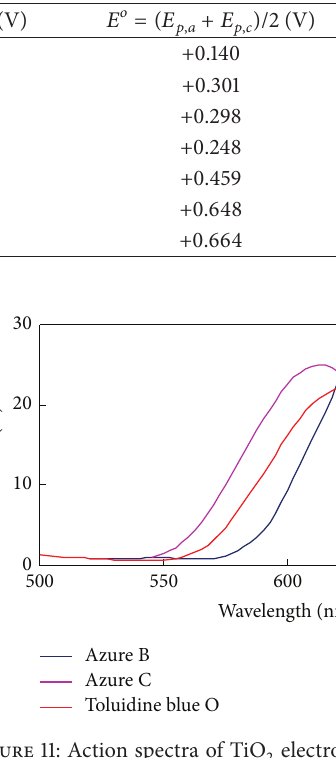
Figure 10: Photocurrent-voltage characteristics of solar cells based onaTiO 2 thinfilmelectrodesensitizedbythiazinebaseddyesunder illumination of 100mW/cm 2 light intensity.